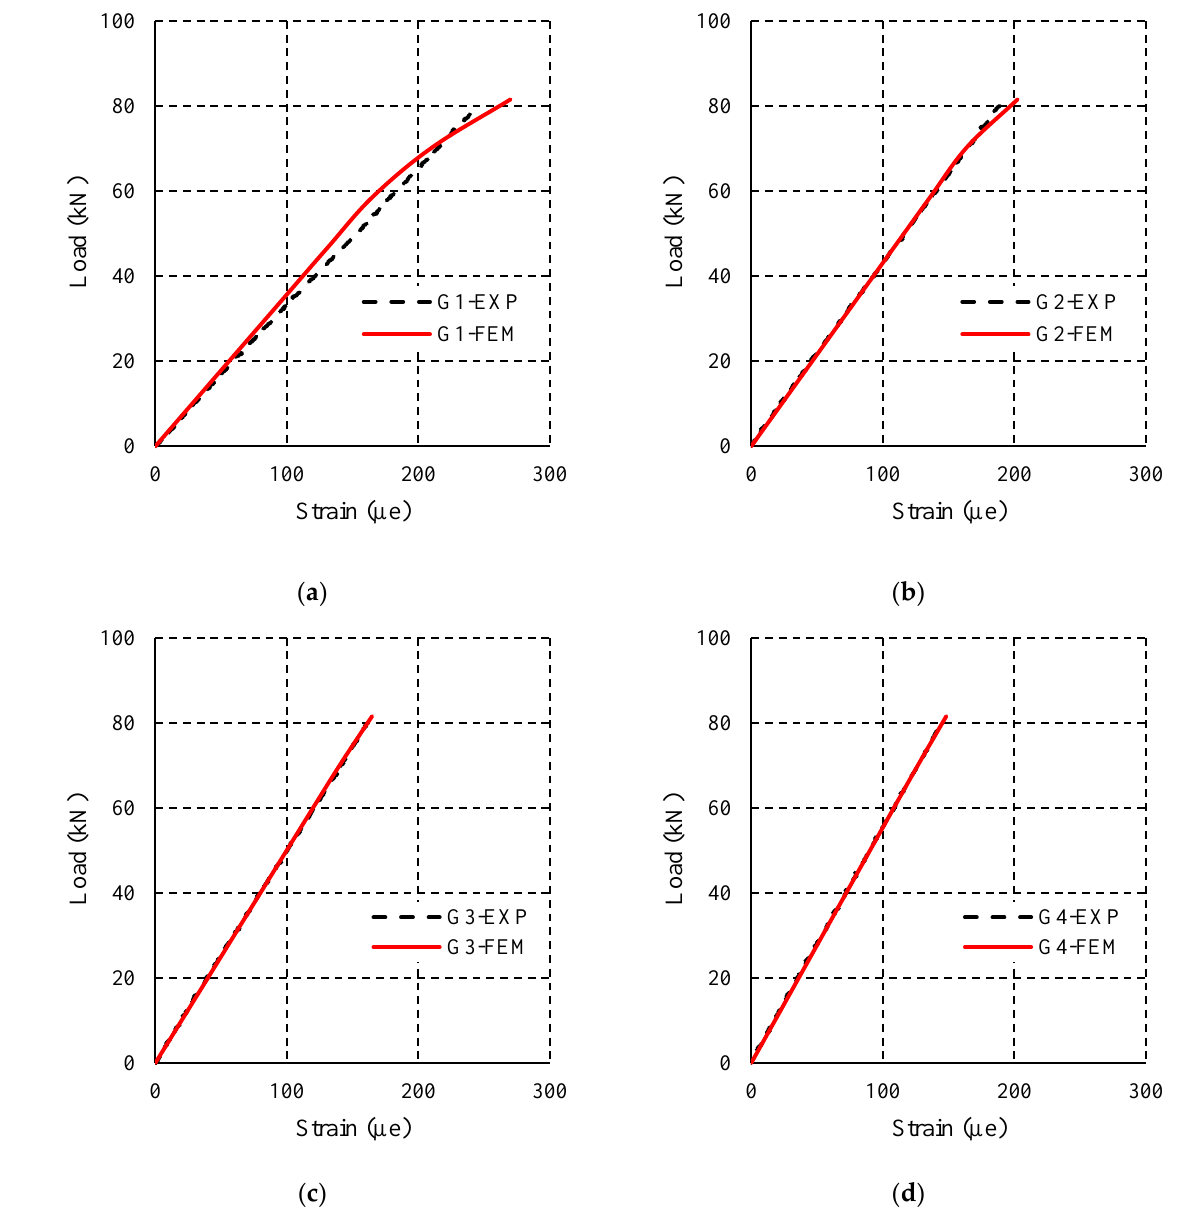
Figure 9. Validated load – strain response of individual adjacent girders: ( a ) load – strain response of girder G1, ( b ) load – strain response of girder G2, ( c ) load – strain response of girder G3, and ( d ) load – strain response of girder G4.